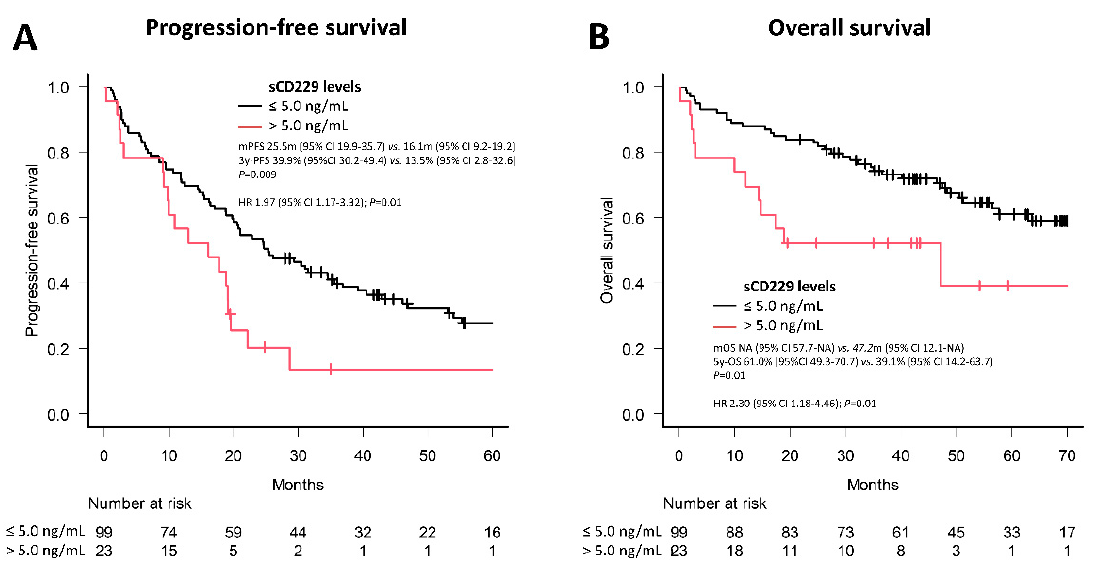
Figure 8. Kaplan ‐ Meier analysis was performed to determine progression ‐ free survival ( A ) and overall survival ( B ) of 122 newly diagnosed MM patients according to whether their baseline sCD229 was above or below the cut ‐ off point of 5.0 ng/mL.